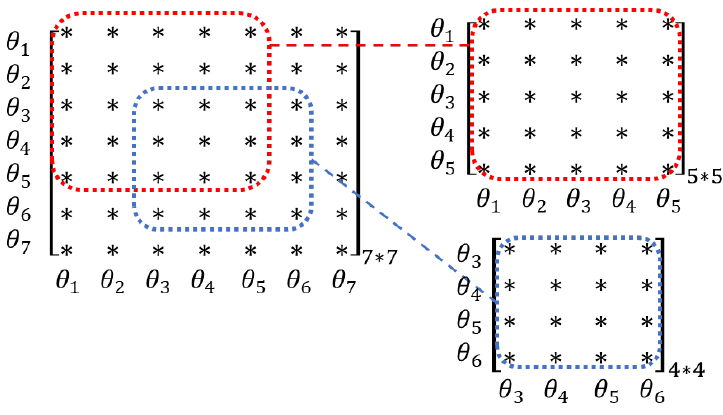
Figure 3. The “Full” FIM ( left ) can easily generate the FIMs for fitting subsets of parameters ( right ). For a specific parameter clustering result, the determinant of the FIM (i.e., D-optimality [4,29]) can be calculated for each parameter subset in every experimental design. As shown in Equation (7), this defines the vectors of the informativeness in a similar form as the sensitivity vectors in Section